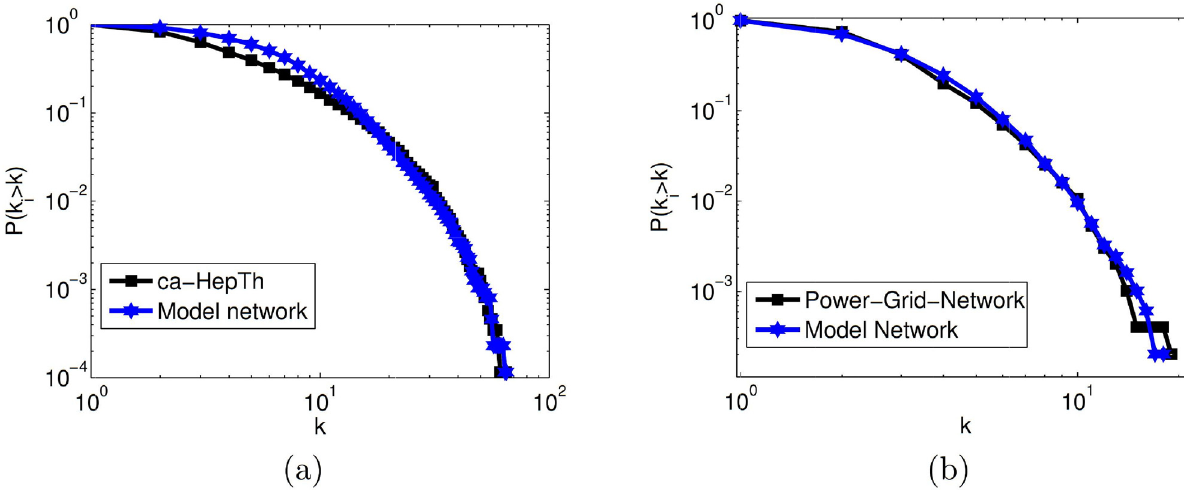
Fig 6. (a) Cumulative degree distribution of collaboration network (in black) and Model network (in blue). The parameter values are β = 0.15, α = 3.8 and b = 0.05. (b) Cumulative degree distribution of power grid network (in black) and Model network (in blue). The parameter values are β = 0.5, α = 0.26 and b =